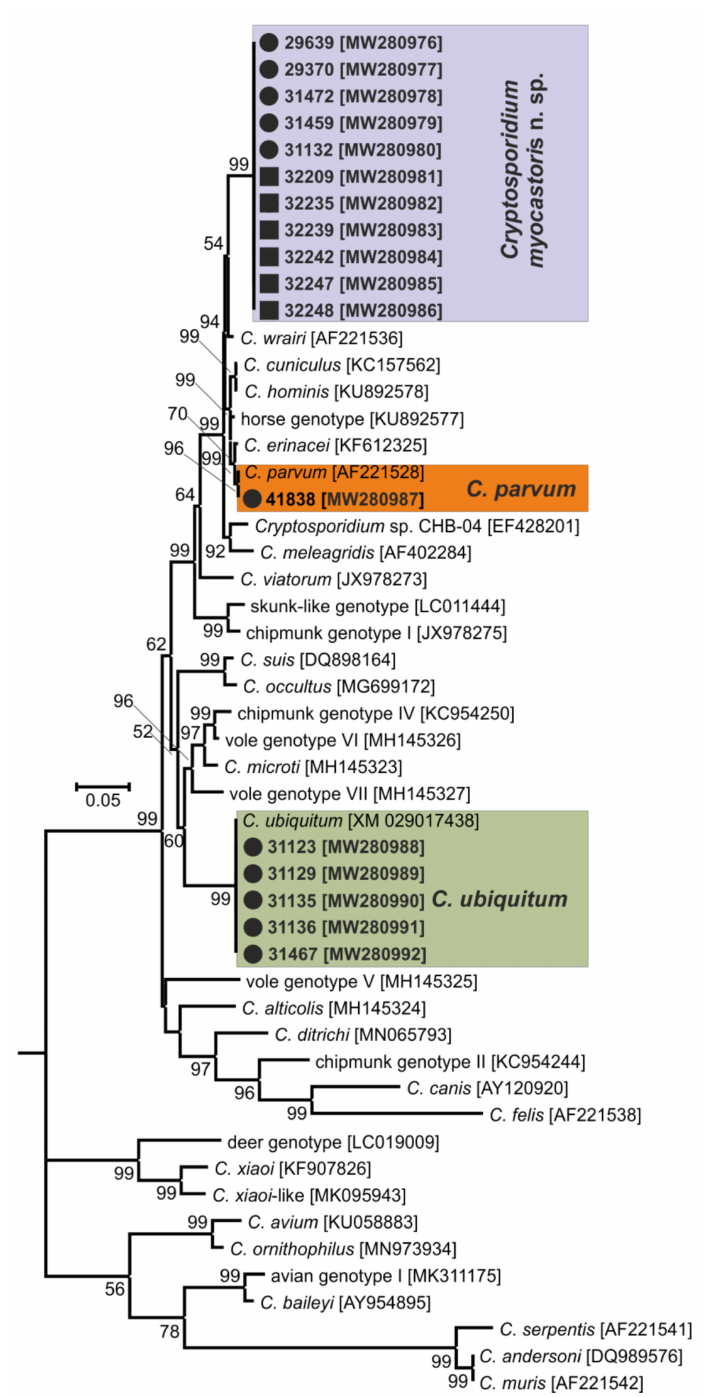
Figure 4. Maximum likelihood tree based on 70 kDa heat shock protein ( HSP70 ) gene sequences of Cryptosporidium spp., including sequences obtained in this study (bolded and highlighted). The alignment contained 1172 base positions in the final dataset. Numbers at the nodes represent the boot strap values with more than 50% boot strap support from 1000 pseudo replicates. The branch length scale bar, indicating the number of substitutions per site, is given in the tree. Sequences from this study are identified by an isolate number (e.g., 32247). Black circles and squares indicate natural and experimental infections,